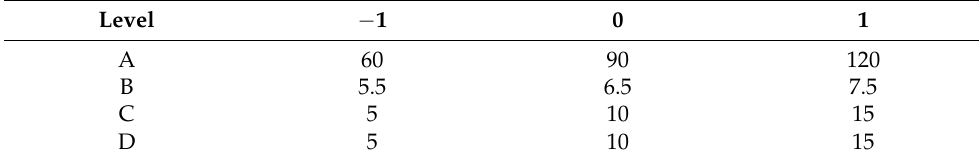
Table 2. The Box–Behnken design and corresponding observed